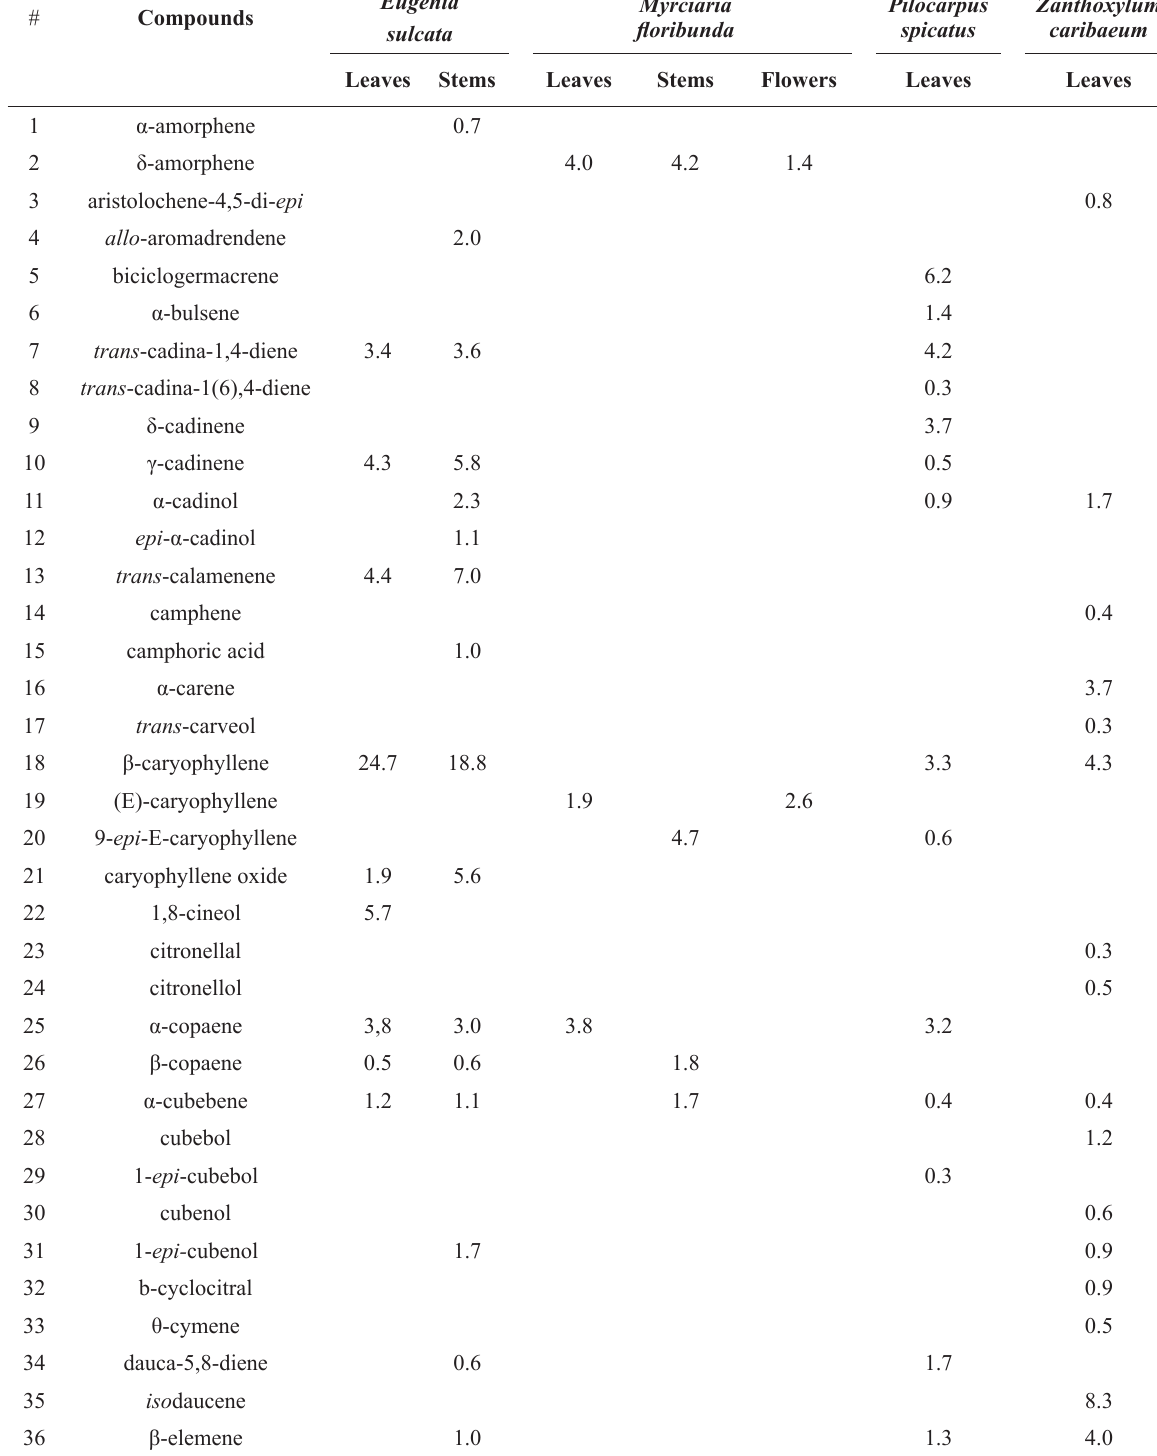
Composition of essential oils constituents of parts from: Eugenia sulcata, Myrciaria floribunda, Pilocarpus spicatus, Zanthoxylum caribaeum by GC/MS (% obtained by GC/FID peak-area